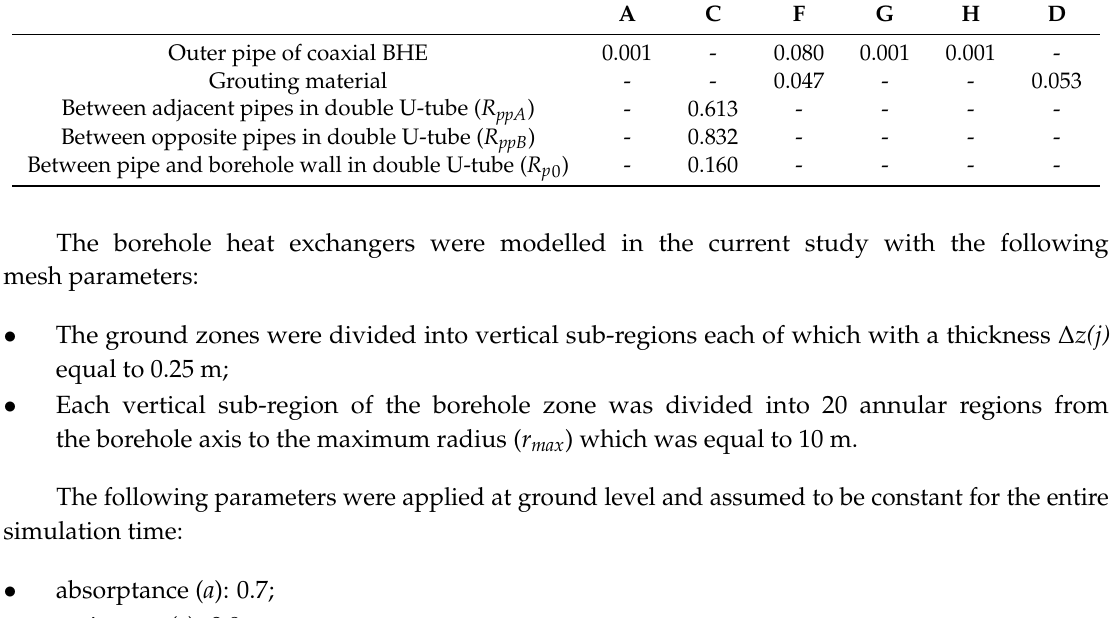
Table 6. Thermal resistances of the borehole heat exchangers. Thermal Resistance [(m K)/W] Outer pipe of coaxial BHE Grouting material Between adjacent pipes in double U-tube ( R ppA ) - Between opposite pipes in double U-tube ( R ppB ) Between pipe and borehole wall in double U-tube ( R p 0